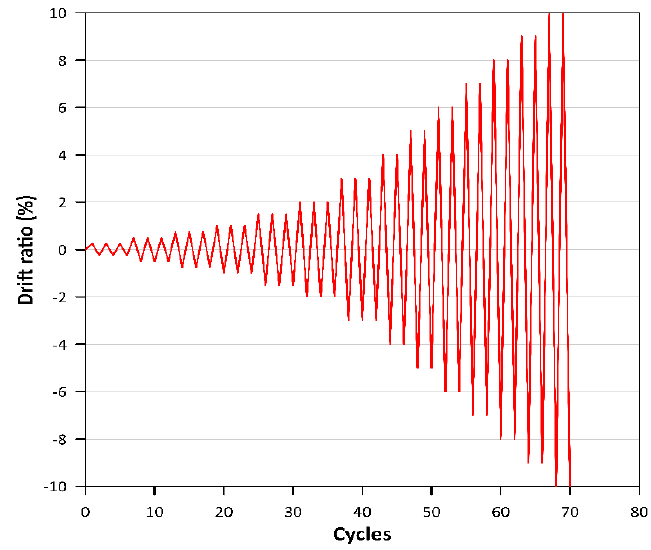
Figure 4. Loading protocol.